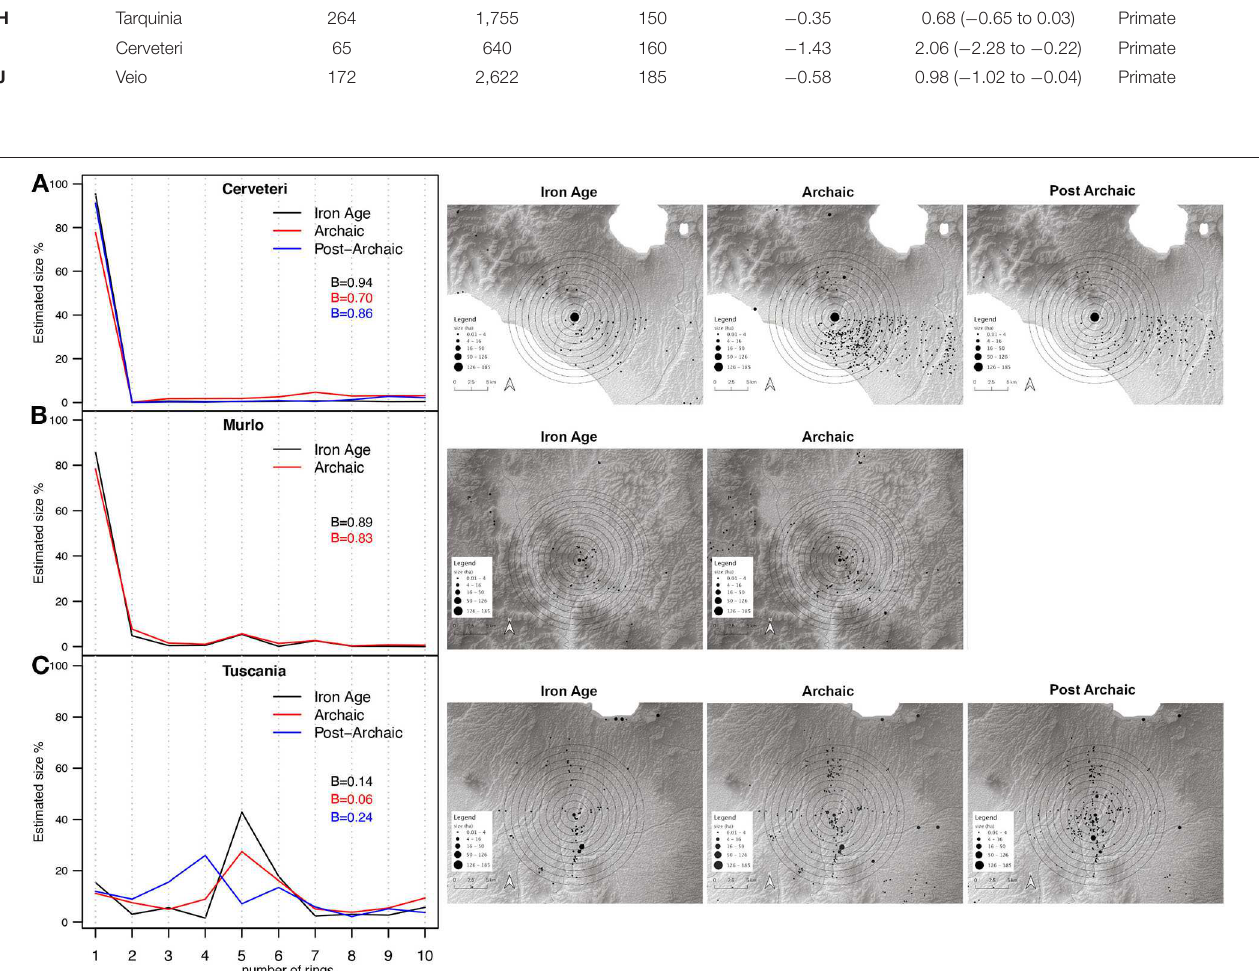
FIGURE 10 | Graphs (left) and maps (right) showing the distribution of estimated settlements size across 10 concentric rings surrounding Cerveteri (A) , Murlo (B) , and Tuscania (C) . The rings are ordered from innermost to outermost (left to right). Veio is not included in this analysis because of the absence of robust site size data. Murlo was not occupied in the Post-Archaic